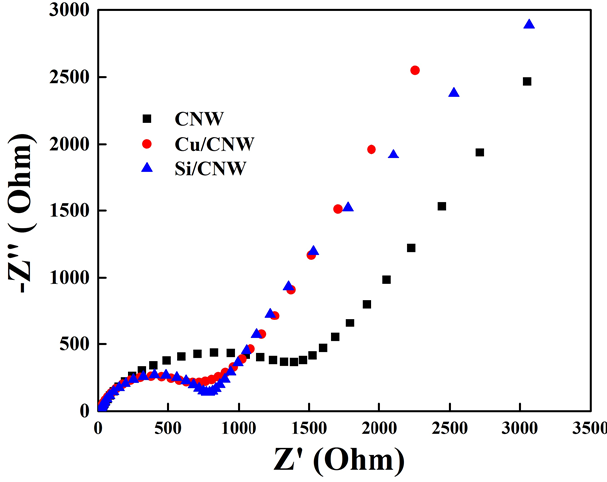
Figure 8. Impedance spectra of LIBs based on CNW (a), Cu − CNW, and Si − CNW.